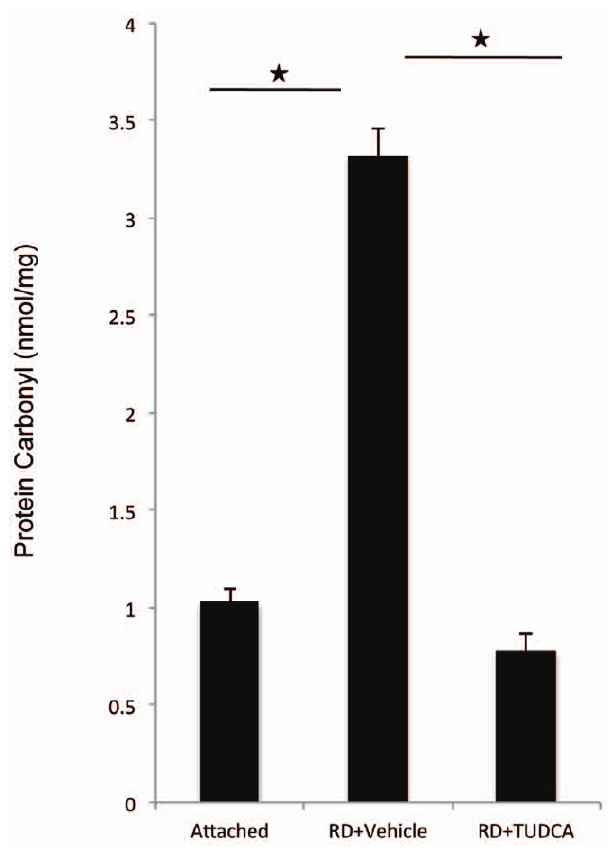
Figure 3. TUDCA diminishes oxidative stress after RD. Levels of protein carbonyl adducts can be used as an index of exposure to oxidative stress. The increase in the protein carbonyl concentration 24 hours after RD as measured by ELISA, was completely reversed with TUDCA treatment (administered as in Figure 1 (A), n=6, p , 0.05).